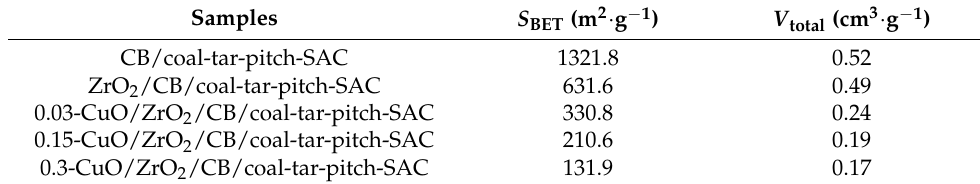
Figure 4. Pore size distribution curves of CB/coal-tar-pitch-SAC ( e ), ZrO 2 /CB/coal-tar-pitch-SAC ( d ) and CuO/ZrO 2 /CB/coal-tar-pitch-SAC materials ( a – c ). Table 1. Characteristic parameters of structures and specific surface areas of CB/coal-tar-pitch-SAC, ZrO 2 /CB/coal-tar-pitch-SAC and CuO/ZrO 2 /CB/coal-tar-pitch-SAC materials. S BET = total BET surface area; V total = total pore volume.